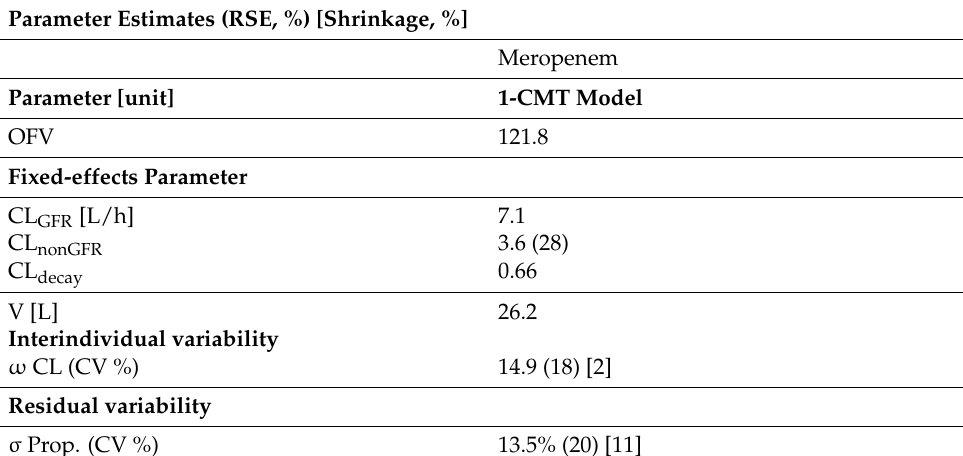
Table 2. Parameter estimates of the population pharmacokinetic model.